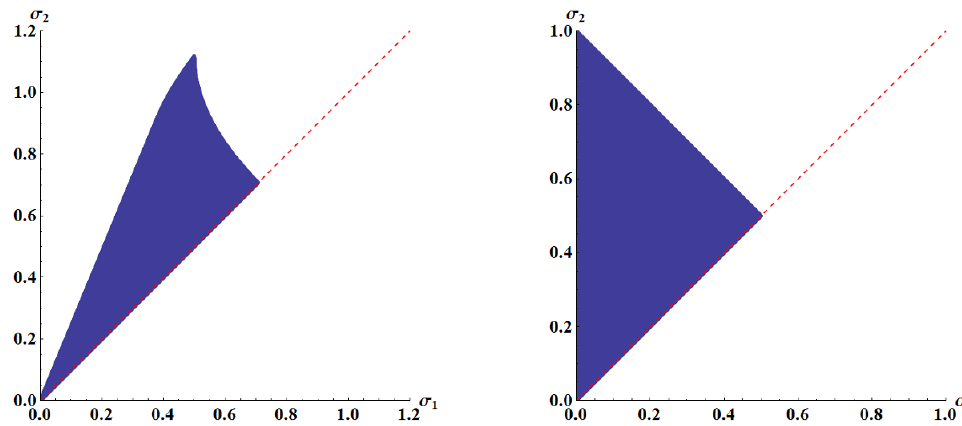
Figure 3 . Left : the gauge coupling dependence of (cid:27) 1 and (cid:27) 2 in the case ( ii ). We change E 1 ; E 2 as 0 (cid:20) E 1 ; E 2 (cid:20) 0 : 5 and set z = 1 + i . Right : the gauge coupling dependence of (cid:27) 1 and (cid:27) 2 in the case ( iii ). We change E; M as 0 (cid:20) E; M (cid:20) 0 : 5. The dotted line denotes (cid:27) 2 = (cid:27) 1 in both (cid:12)gures.